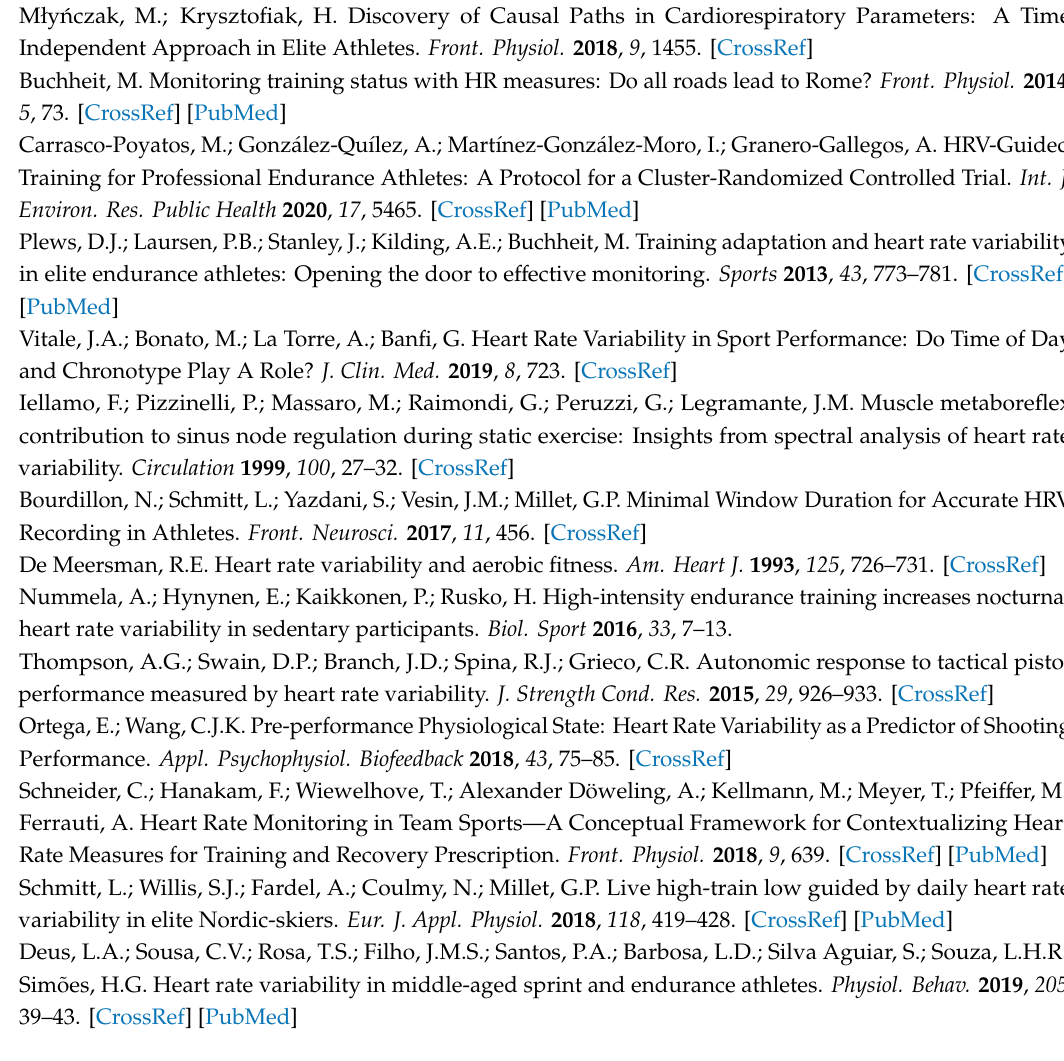
Figure S1: Relationship among di ff erences between sympathetic nervous system activity (SNSa) stimulation and Baseline in heart rate variability (HRV) parameters (Parameter-di ff ) and heart rate (HR) (HR-di ff ) (A) and respiratory rate (RespRate) (RespRate-di ff ) (B), Table S1: Individual athletes’ responses in heart rate (HR) and respiratory rate (RespRate) during sympathetic nervous system activity (SNSa) stimulation, Table S2: Individual athletes’ responses in standard deviation of normal-to-normal RR intervals (SDNN) and root mean square of successive di ff erences (RMSSD) parameters during sympathetic nervous system activity (SNSa)